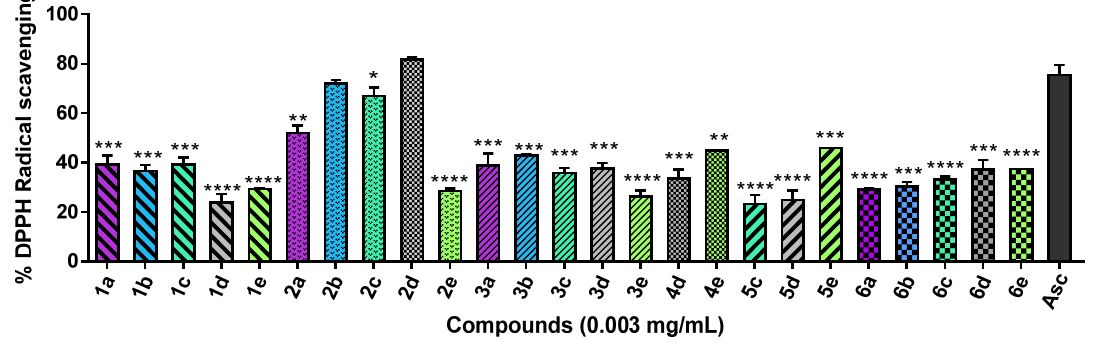
Figure 2. DPPH radical scavenging activity, expressed as percentage, for the selenoureas presented herein. DPPH • scavenging at 0.003 mg/mL after 30 min of treatment. Selenoureas 4a , 4b , 4c , 5a , and 5b were degraded before the DPPH assay was realized. Significance: * p < 0.05, ** p ≤ 0.01, *** p ≤ 0.001 and **** p ≤ 0.0001 compared with Asc. Results obtained for oher concentrations and incubation times are included in the Supplementary Material (Figures S81–S100).